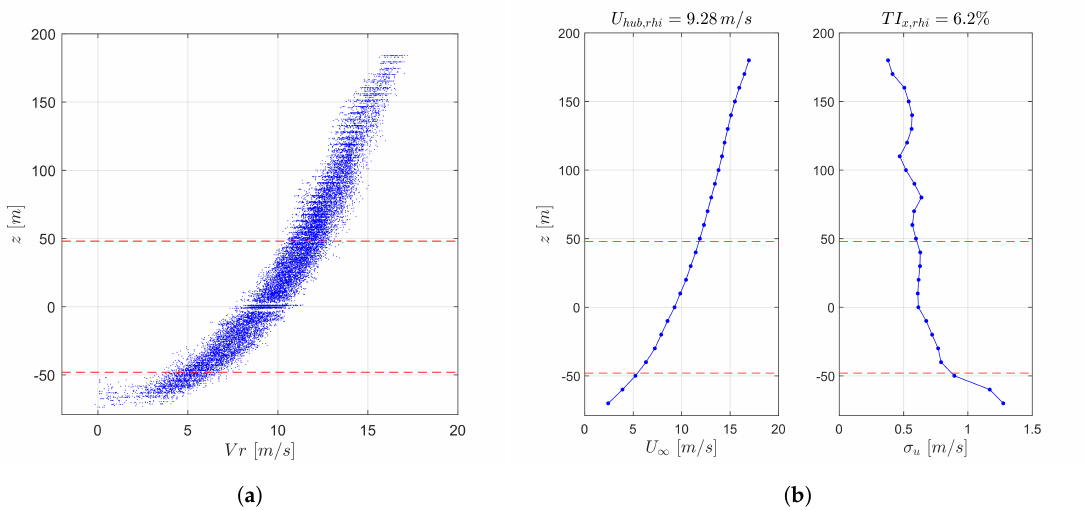
Figure 6. Example of the characterization of the vertical profile of horizontal velocity with range height indicator (RHI) scans. The red dashed lines indicate the upper and lower limits of the rotor. ( a ) All measurements; ( b ) Binned statistics. 22h35–22h40, 15 September